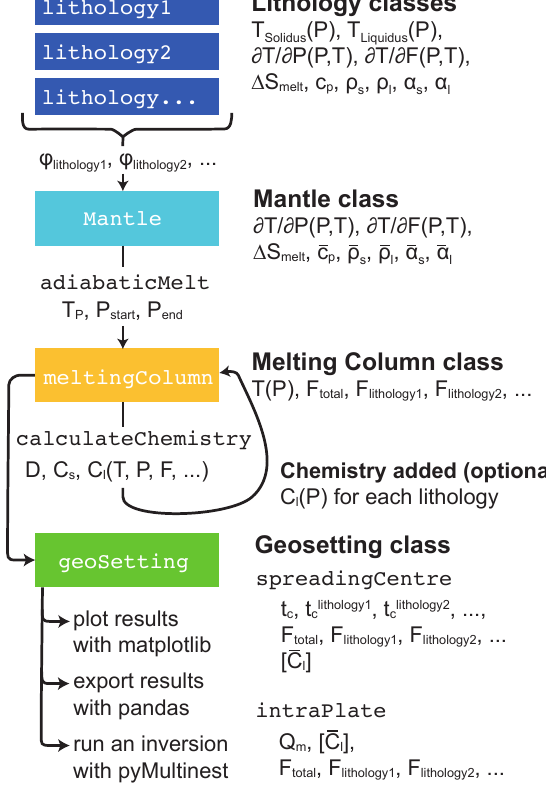
Figure 1: Summary of the structure of pyMelt . Each box rep- resents an instance of a pyMelt object, either created directly by the user (with user-defined variables as specified on the ar- rows) or returned by a method call. The properties and meth- ods of each class of objects are shown on the right hand side (symbols as defined in the